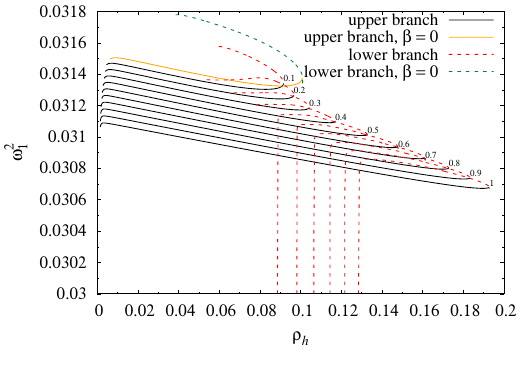
Figure 15 . The lowest eigenvalue, ! 2 , of the linear perturbation of the pro(cid:12)le function, f 0 , in the 1 2 + 4 + 12 model. The numbers on the (cid:12)gures indicate the di(cid:11)erent values of (cid:12) = 0 ; 0 : 1 ; : : : ; 1. The upper and lower (cid:12) = 0 branches are shown in orange and dark green colors,